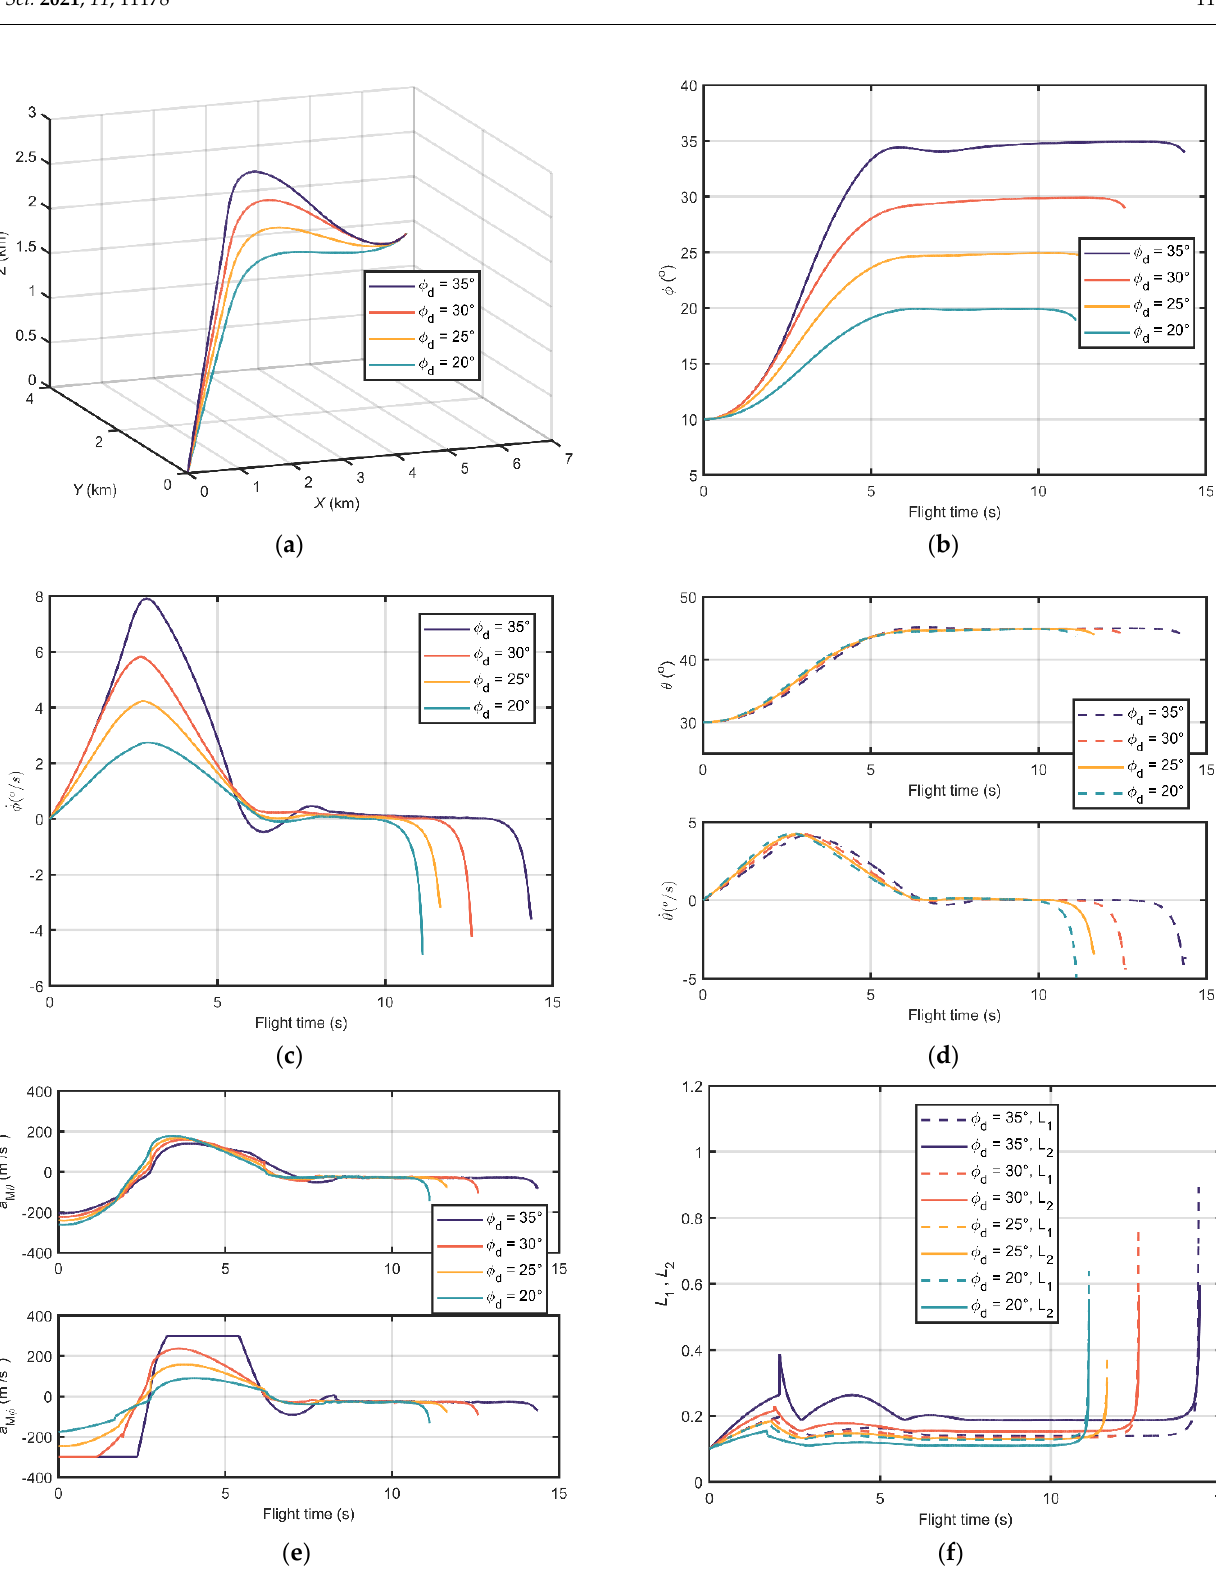
Figure 3. The simulation results under various desired terminal elevation angles: ( a ) Relative distance trajectories between missile and target; ( b ) Elevation angles; ( c ) Elevation angular rates; ( d ) Azimuth angles and azimuth angular rates; ( e ) Output accelerations; and ( f ) The adaptive gains of the barrier function-based super-twisting guidance law.